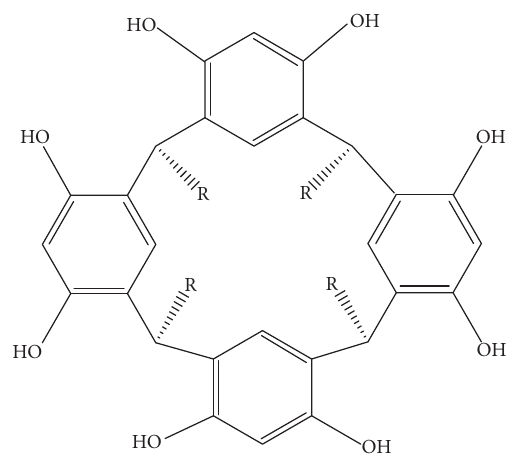
Figure 4: Resorcinarene structure (RESO).